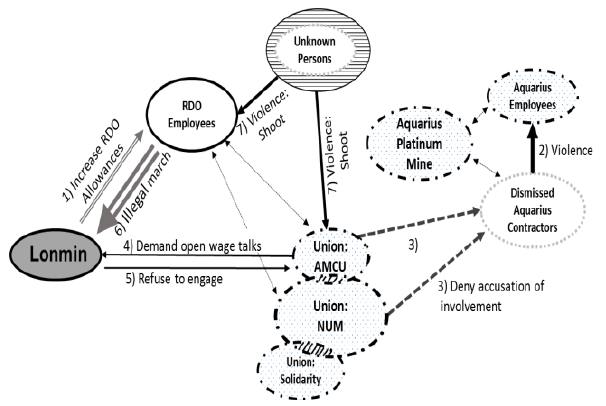
Figure 3: Stakeholder model for Lonmin (Period 1 to 10 August) Period 11 to 15 August